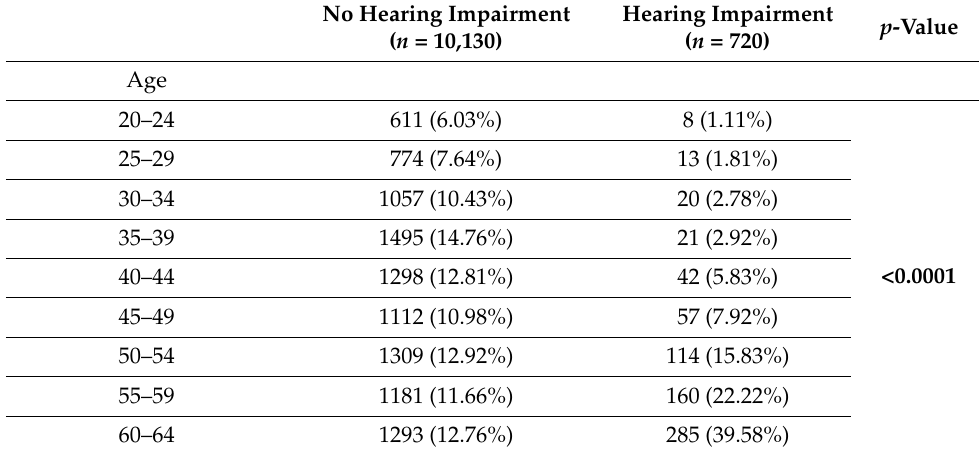
Table 1. Clinical characteristics of subjects